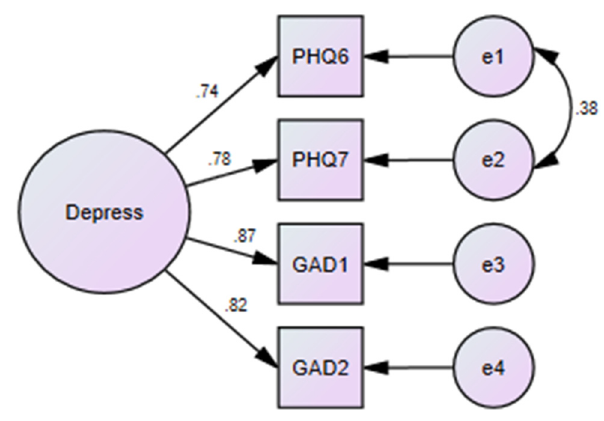
Figure 2. Model fit for the PHQ-4 as per confirmatory factor analysis.